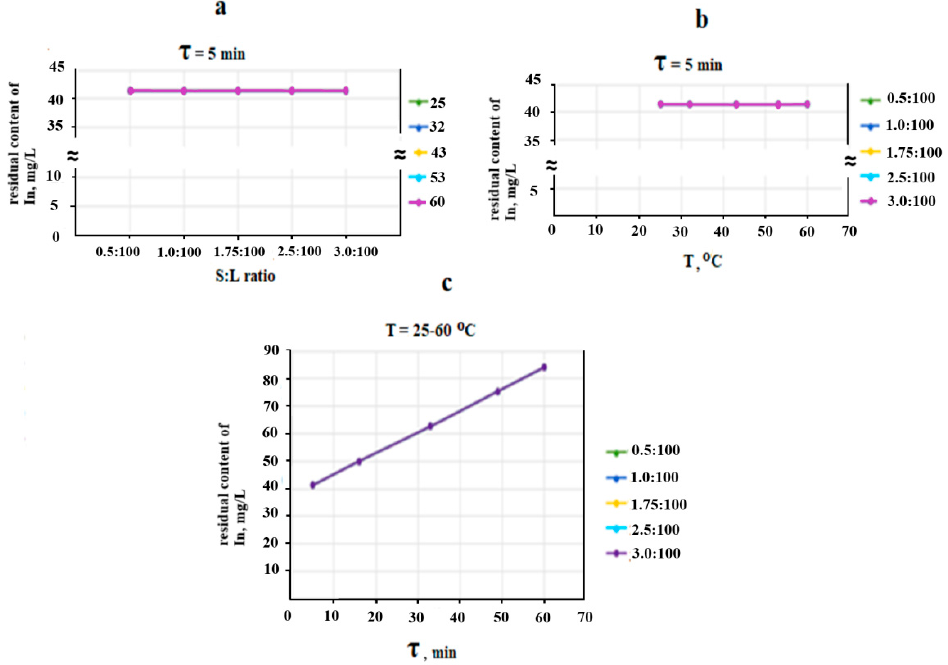
Figure 1. Influence of the studied factors on the residual content of In 3+ in the liquid phase of the “natural zeolite–In 3+ – Н 2 О ”system.( a ) S:L ratio; ( b ) temperature, ° С ; ( c ) time, min.